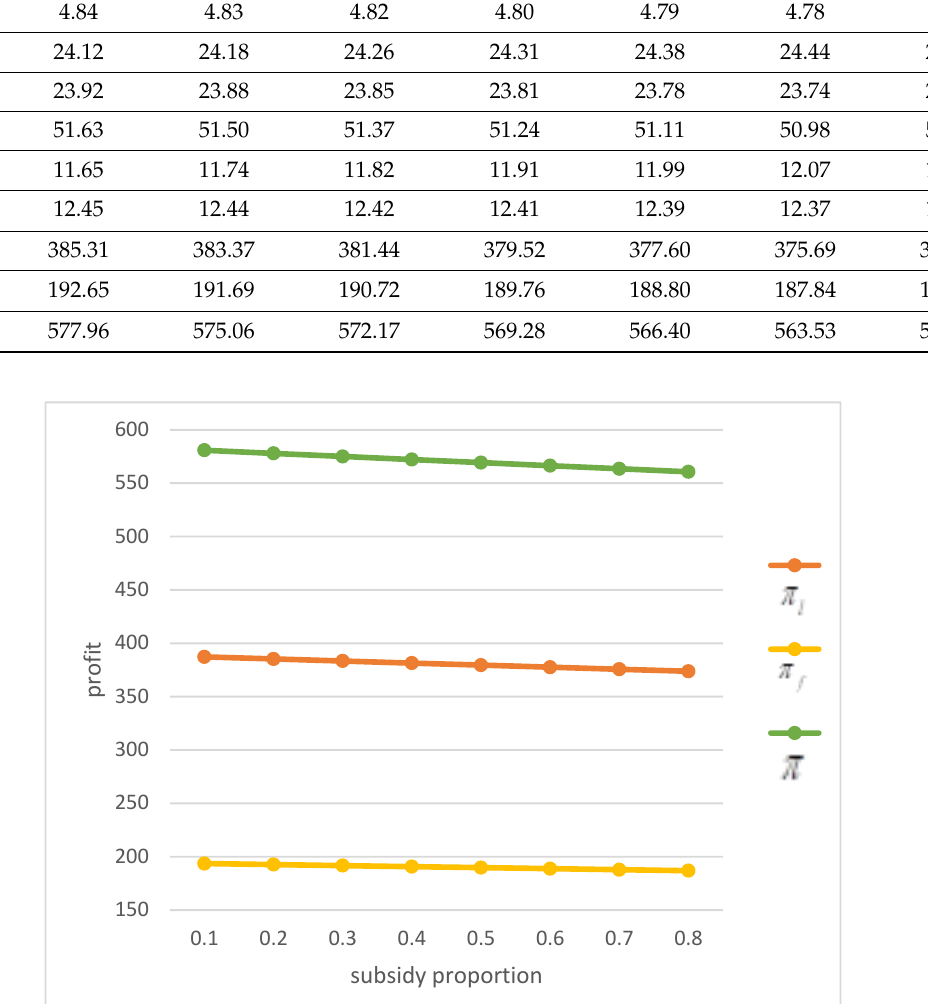
Figure 2. Sensitivity analysis of changes in the proportion of government subsidies.